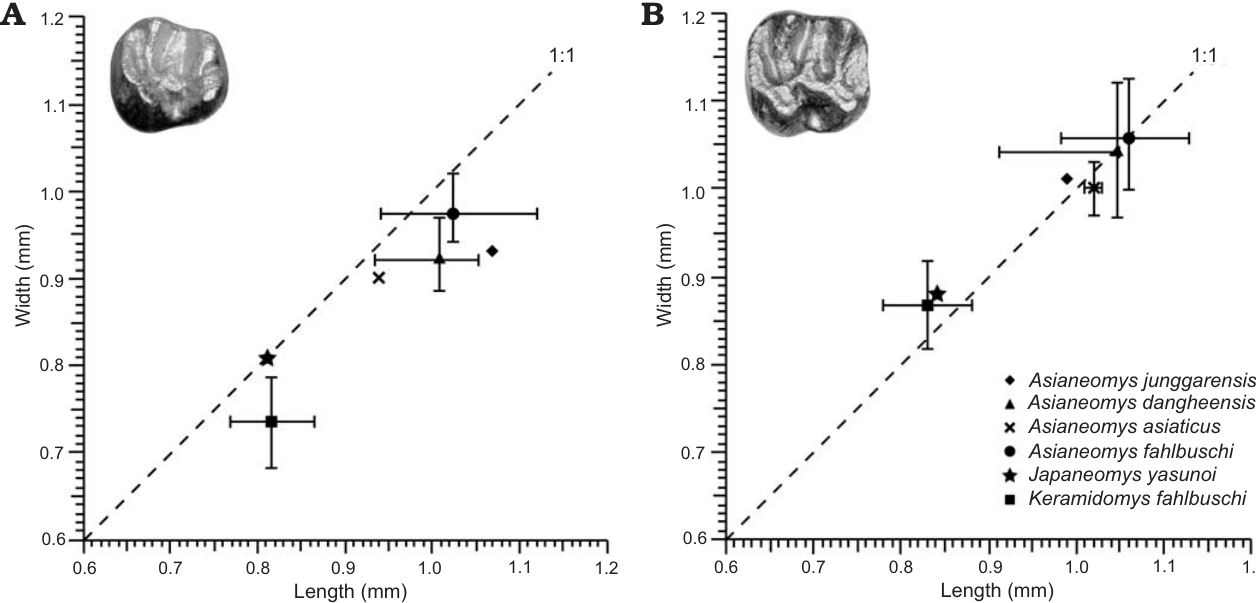
Fig. 3. Tooth measurements of Japaneomys , Asianeomys , and Keramidomys . Each symbol represents the mean of measurements, which were taken from the primary literature (Wang and Emry 1991; Wang 2002; Wu et al. 2006; Maridet et al. 2015; Qiu and Li 2016). Error bars represent the range of the measurements.